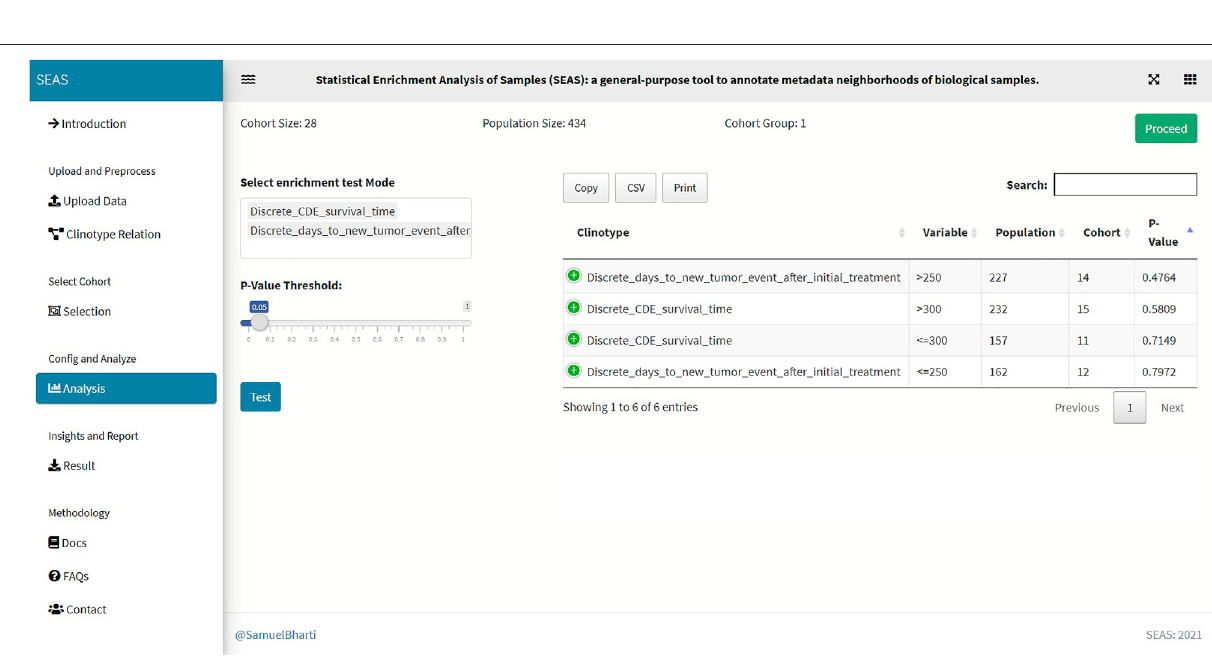
Frontiers in Big Data |